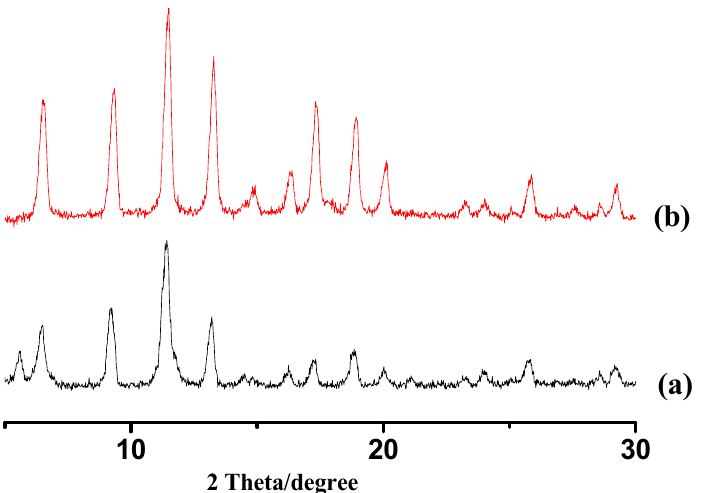
Figure 2. Temporal profile for the fresh ( ■ ), 1st reuse ( ● ) and 2nd reuse ( ▲ ) of Cu 3 (BTC) 2 during the reusability test.